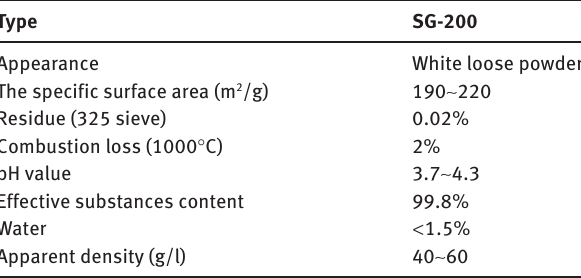
Table 2 Performance parameters of